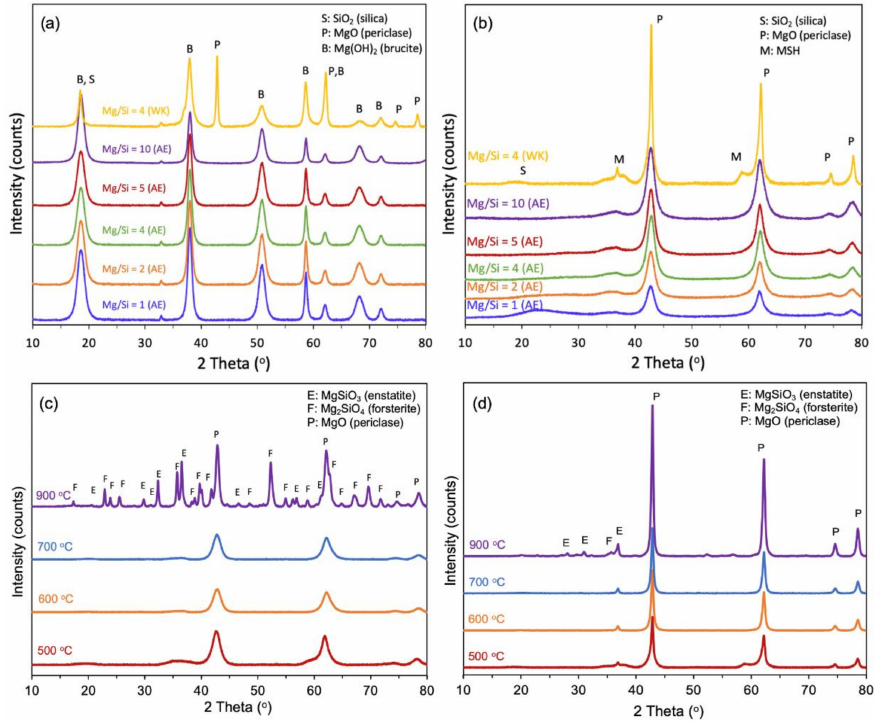
Figure 1. XRD of ammonia-evaporated (AE) MgO-SiO 2 with different Mg/Si loadings and of wet- kneaded (WK) MgO-SiO 2 -4 after ( a ) drying at 80 ◦ C and ( b ) calcination at 500 ◦ C ( c ) MgO-SiO 2 -4 (AE) and ( d ) MgO-SiO 2 -4 (WK) after calcination at various temperatures.